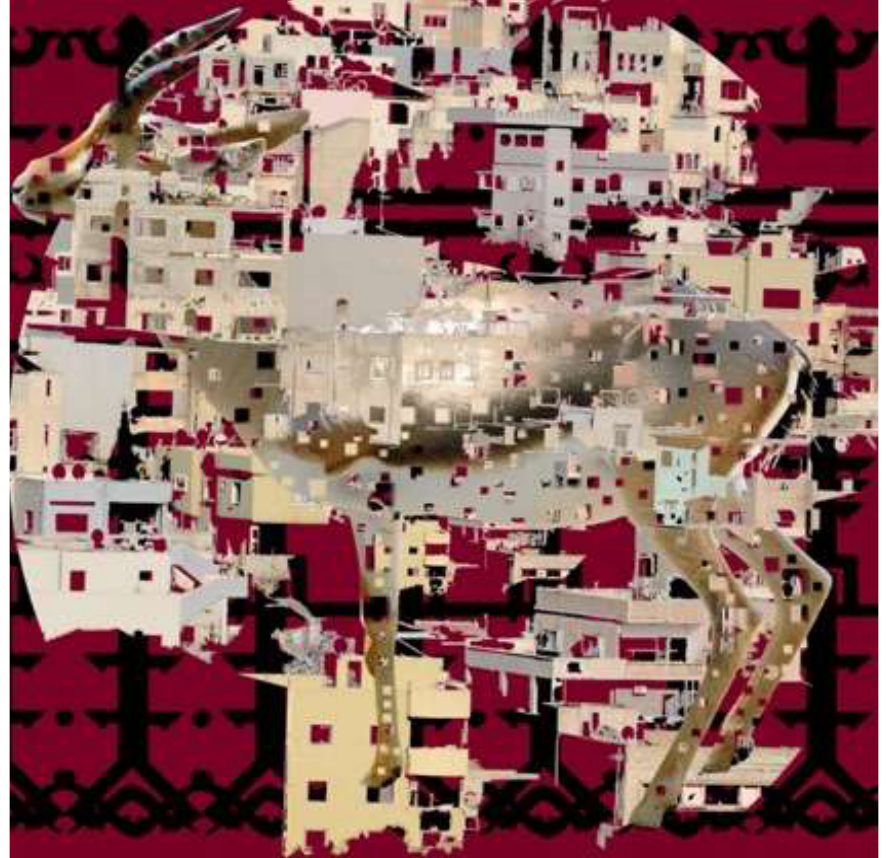
Figure 2. Manal Mahamid, Displacement 1 , Photomontage on archival paper, 92 × 92 cm, 2015, Edition 1 of 4.